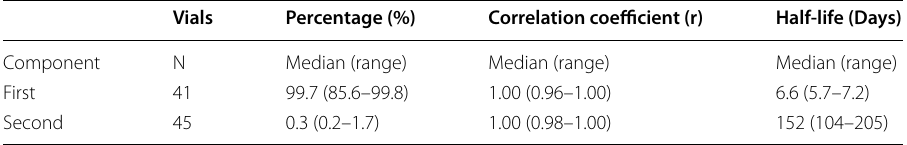
Table 2 Data for radioactive decay curves obtained from sequential measurements of the 45 first vials used Vials Percentage (%) Correlation coefficient (r) Half-life (Days) Component N Median (range)